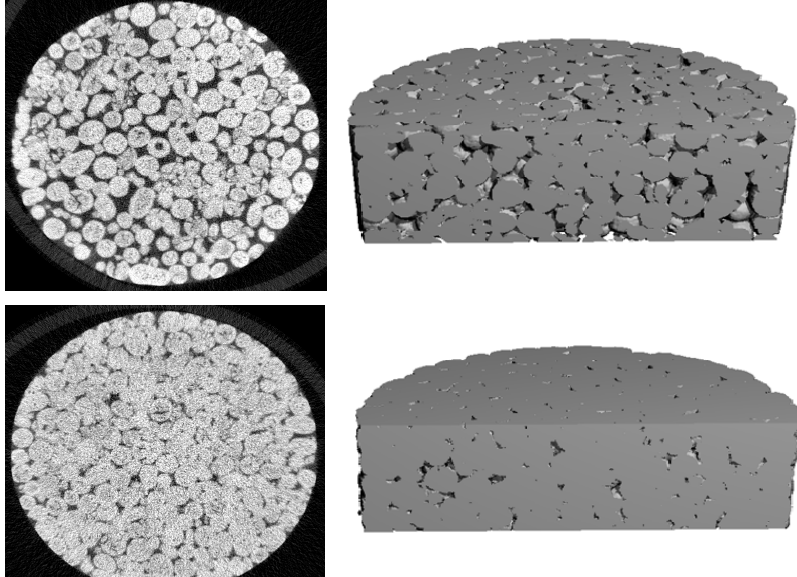
Figure 5. µCT images of preforms compacted at 32 MPa (top) and at 50 MPa (bottom), sintered at 730 °C for 4 h. Left, 2D horizontal section at the mid-plane and right, vertical section of a 3D view at the